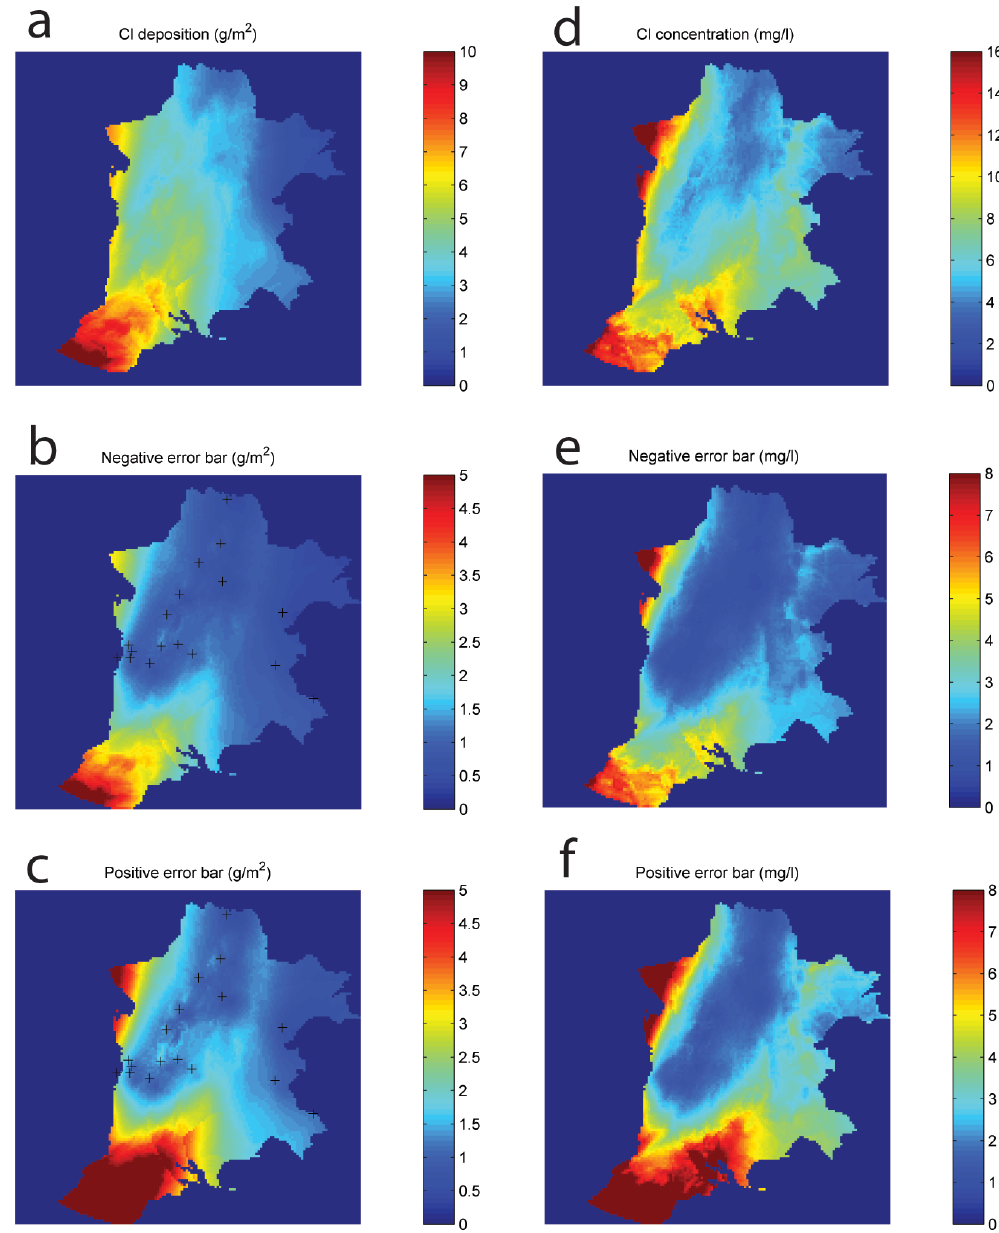
Fig. 6. ASOADeK constructed maps, and their positive and negative uncertainty at a 90% confidence level, for bulk chloride deposition (gm − 2 yr − 1 ) ( a , b , and c ), and for bulk chloride concentration (mgl − 1 ) ( d , e , and f ). The cross symbols on (b) and (c) is the bulk chloride sampling sites (Fig.